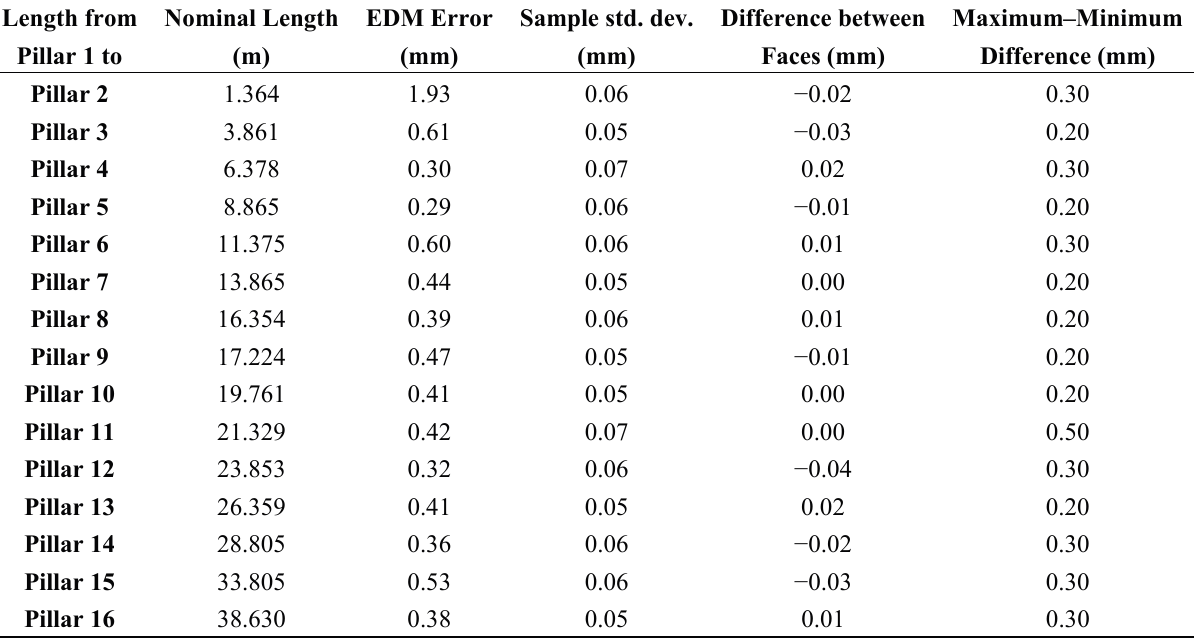
Figure 22. Leica TC2003–Absolute errors in one epoch. Table 10. Leica TC2003 (25 February